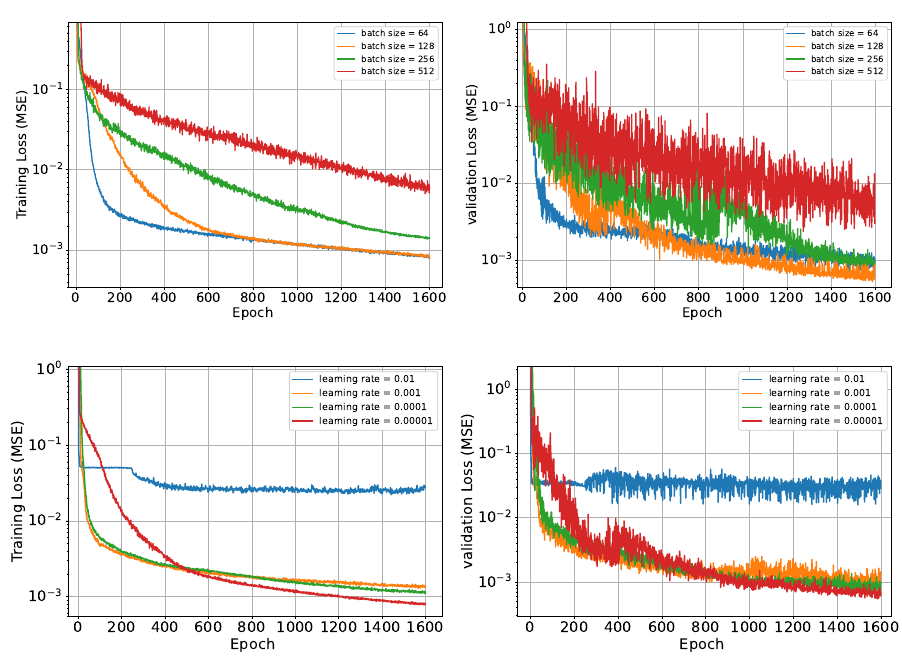
Figure 6. Loss comparison of DNN with different sizes.